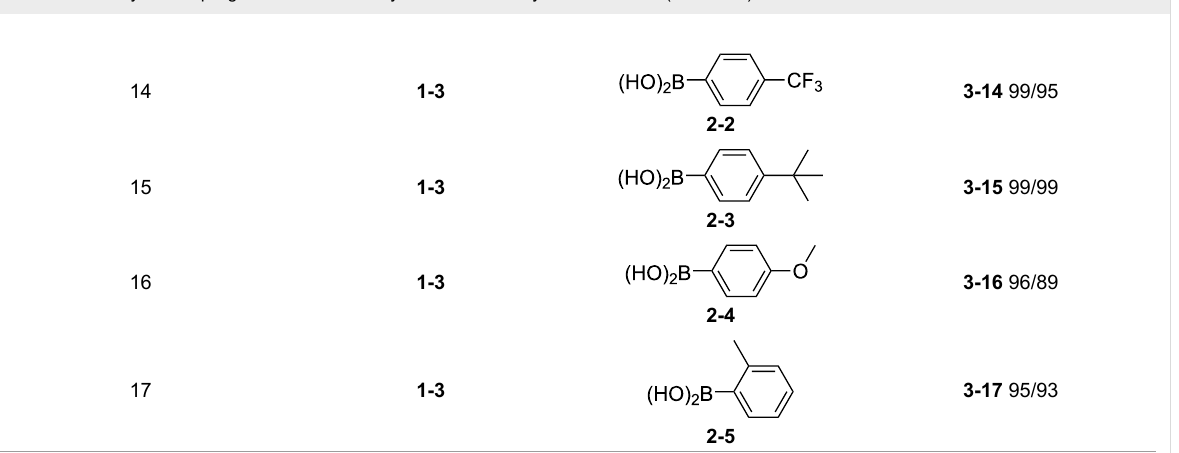
Table 4: Pd-catalyzed coupling between various aryl chlorides and arylboronic acids. a